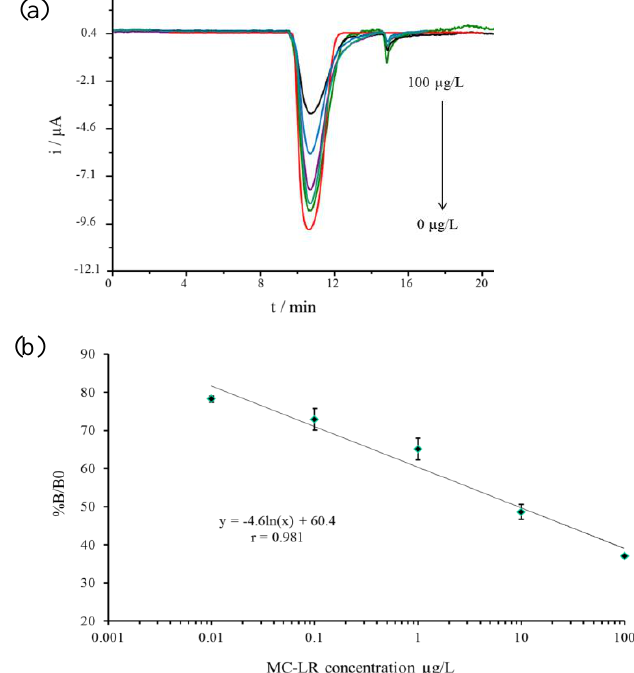
Figure 6. ( a ) Current response of different concentrations of MCLR and blank (0 µg/L); ( b ) standards curve created from concentration between 0.01 and 100 µg/L MCLR.